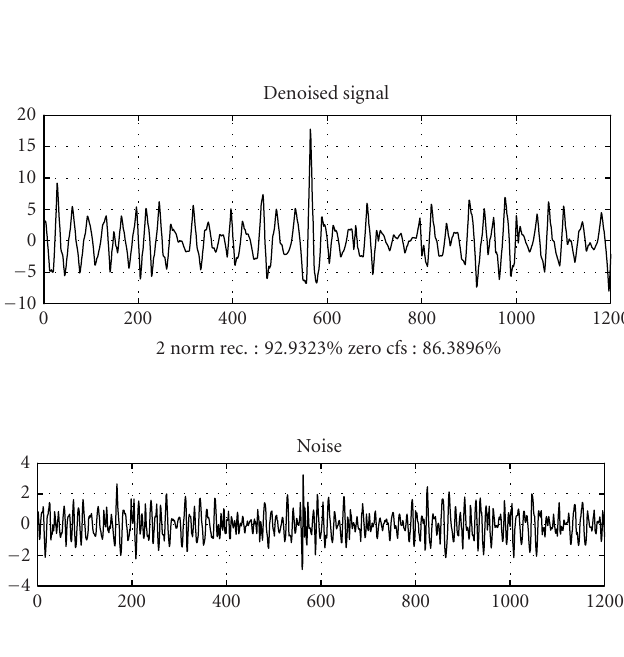
Figure 3.17. Denoising thr. wavelet packet with